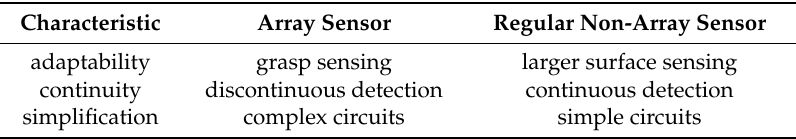
Table 1. Characteristics of tactile